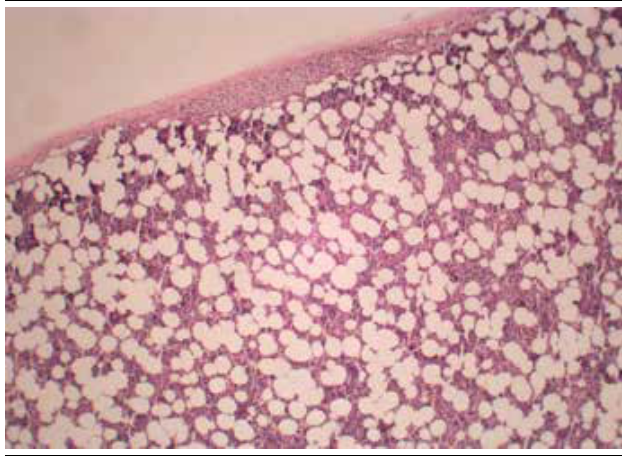
figuRE 3 − Myelolipoma composed of mature adipose tissue and hematopoietic elements, with the presence of fibrous pseudocapsule and rim of adrenal cortex around the lesion (4× magnification)